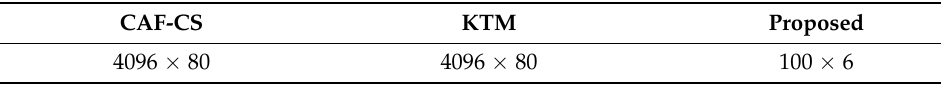
Table 4. Size of the data matrix in transmission.